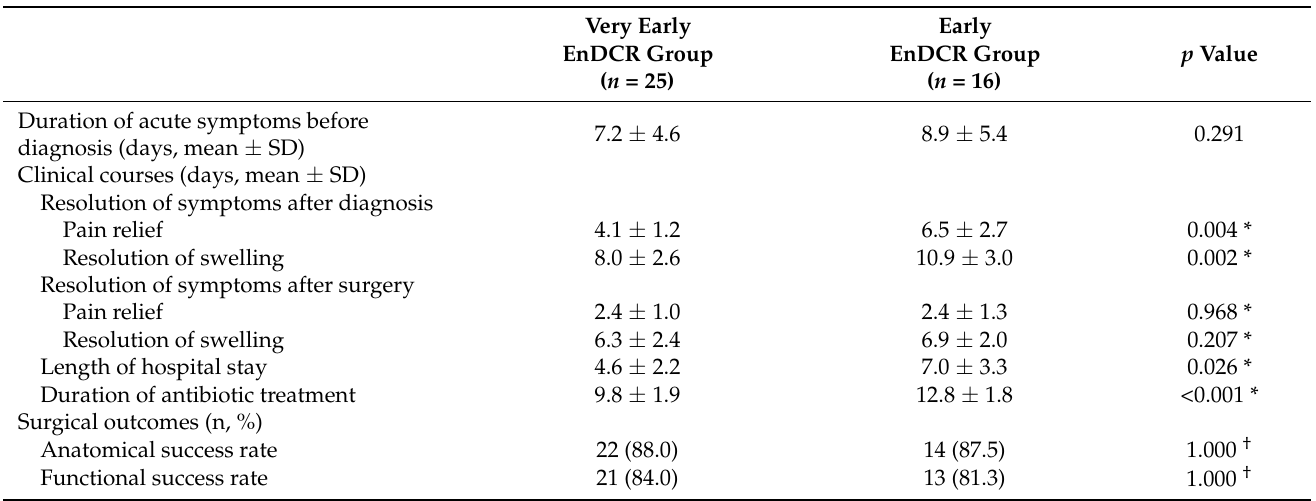
Table 3. Comparison of clinical courses and surgical outcomes between the very early EnDCR group and the early EnDCR